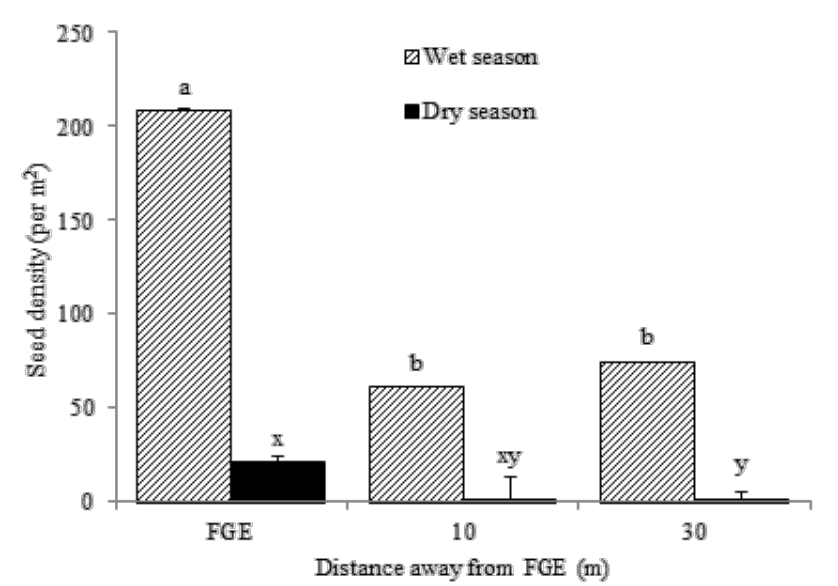
Figure 1: The density of Austroeupatorium inulifolium seeds recorded during wet and dry season soil seed banks at forest- grassland edge (0 m) and 10 and 30 m distances away from the FGE towards the open grassland. Vertical bars represent standard error of the mean (SEM). Different letters indicate significant differences between